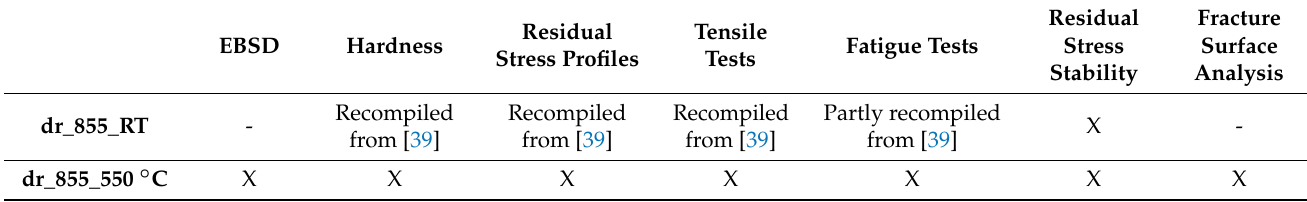
Table 1. Summary of the conducted and recompiled tests for the different conditions considered.